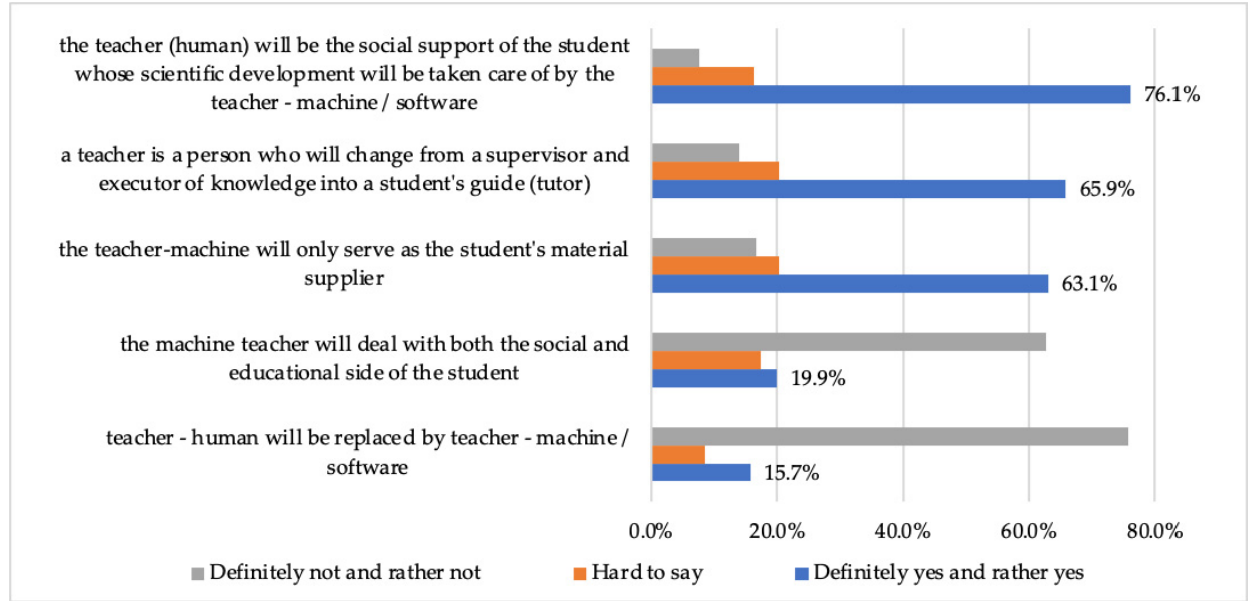
Figure 4. Position of the teacher in the future (in 30